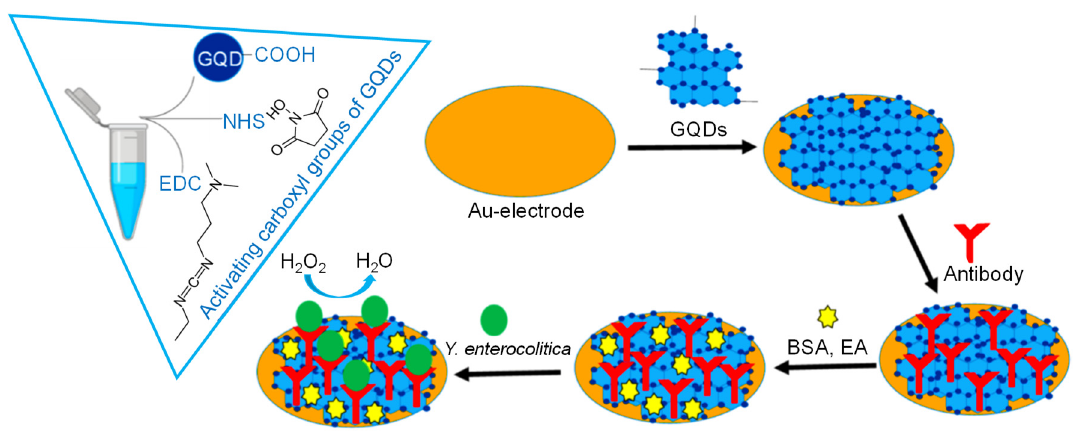
Figure 23. Schematic illustration of a GQD-based antibody sensor for Y. enterecolitica quantification [67].